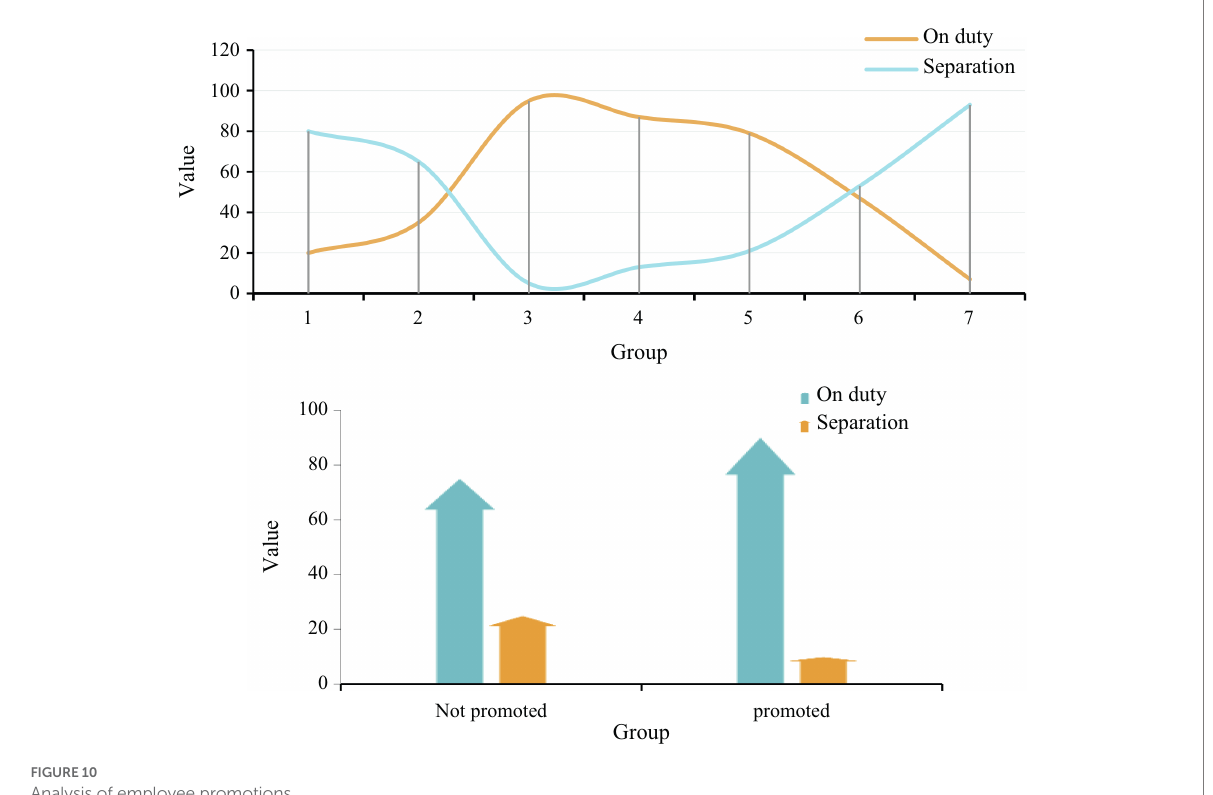
FIGURE 10 Analysis of employee